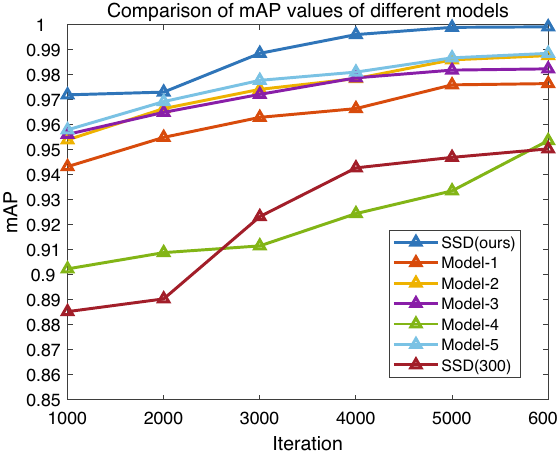
Figure 13. Comparision of mAP values of different models.